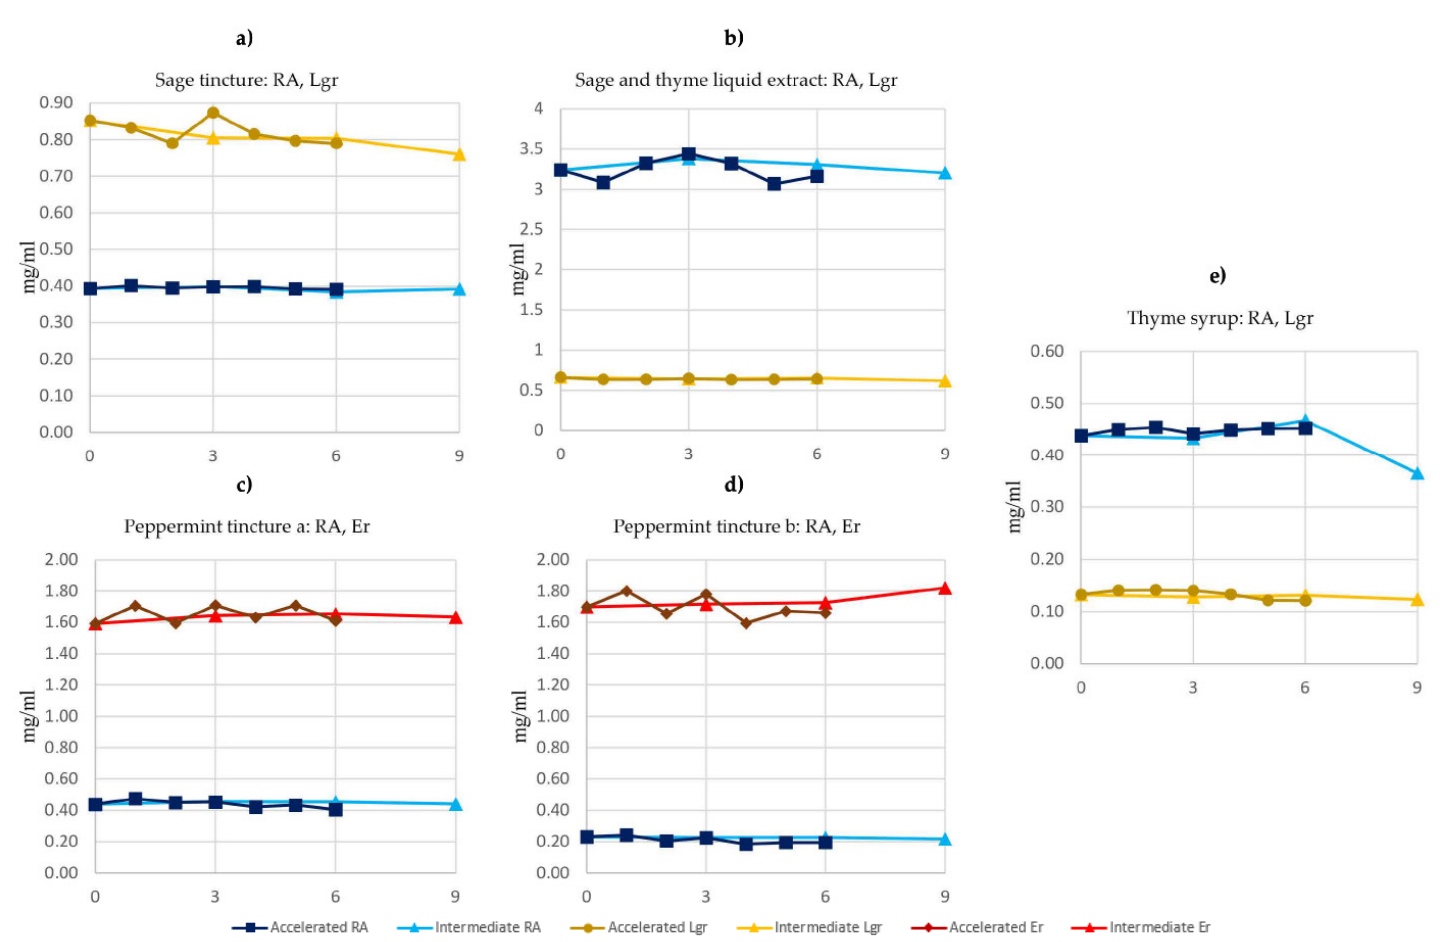
Figure 1. Rosmarinic acid (RA), luteolin-7- O - β -glucuronide (Lgr), and eriocitrin (Er) content in accelerated and intermediate tests of: ( a ) Sage tincture; ( b ) sage and thyme liquid extract; ( c ) peppermint tincture a; ( d ) peppermint tincture b; ( e ) thyme syrup.